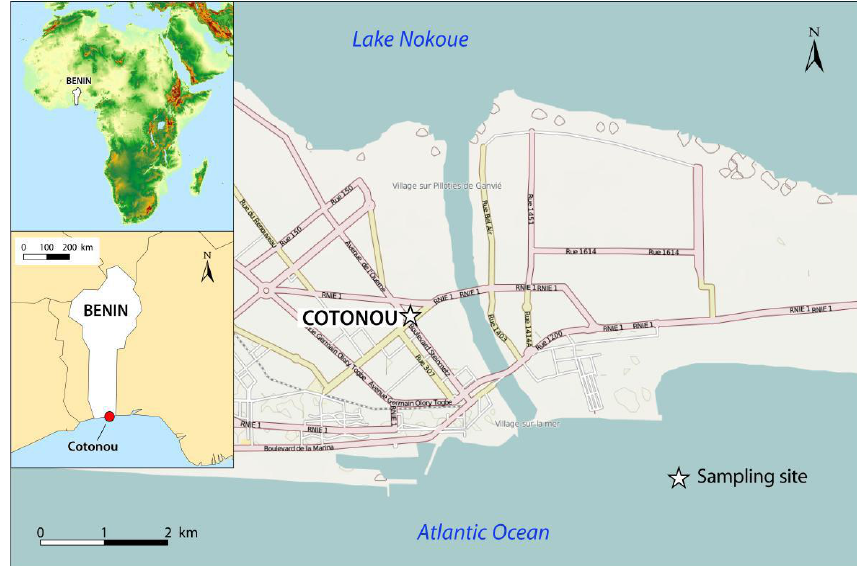
Figure 1. Map of urban sampling site in Cotonou, Benin.